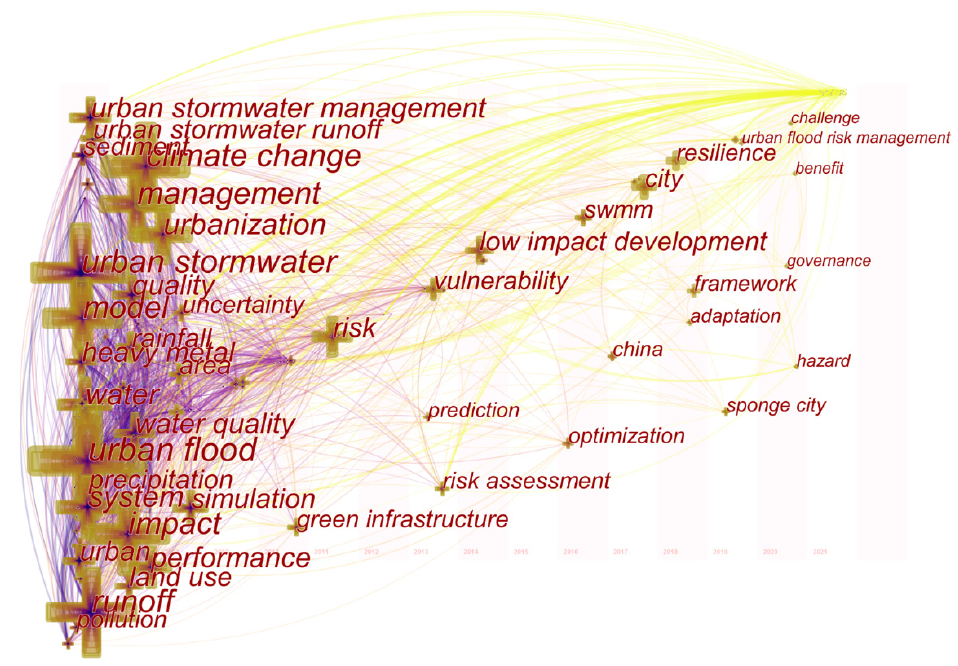
Figure 11. The evolution of subjects in the field of urban floods.